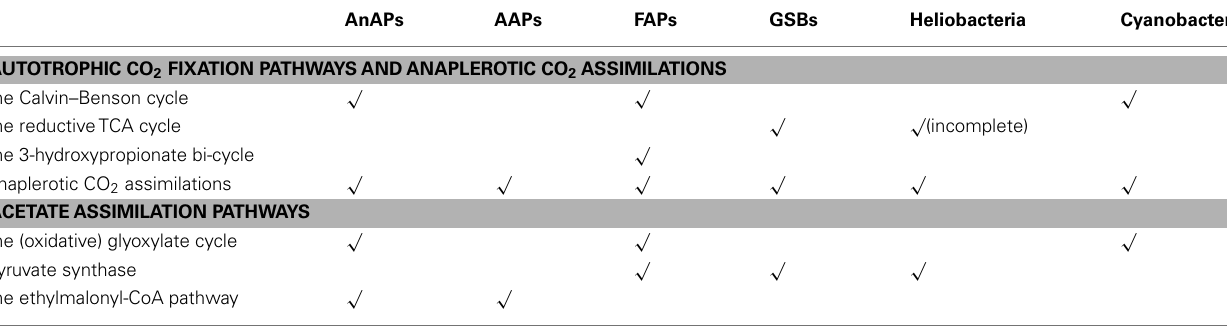
Table 1 | The carbon assimilation pathways reported in phototrophic bacteria. AnAPs